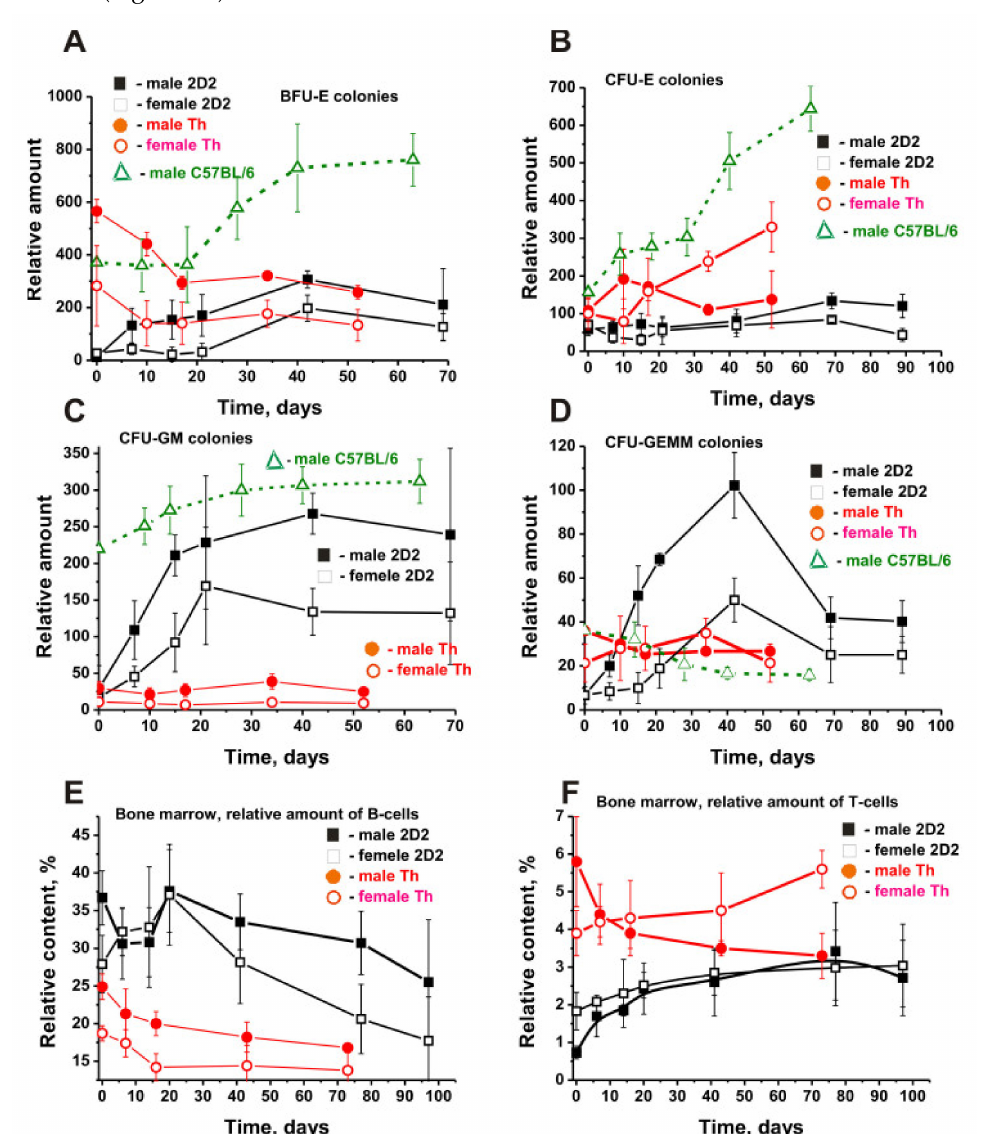
Figure 2. Changes during time-related development of spontaneous EAE in BFU-E ( A ), CFU-E ( B ), CFU-GM ( C ), and CFU-GEMM ( D ) cells as well as in BM relative amounts of B ( E ) and T lymphocytes ( F ) in 2D2 (black symbols), Th (red symbols), and C57BL/6 (green symbols) mice. The number of total cells is calculated for 15,000 bone marrow cells. All dependencies for all lines of males and females are marked in the Figure. For comparison, the C57BL/6 [34–37] and Th [38,39] mice data were taken from our previously published articles. The duration of the experiment and the time of blood sampling were different for different strains of